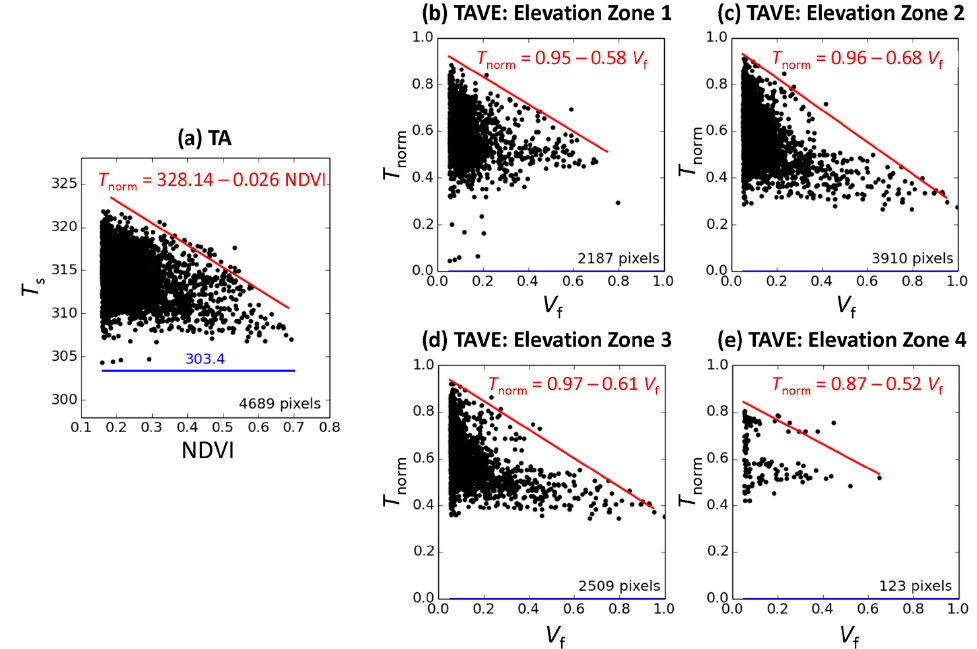
Figure 6. Comparison of temperature-vegetation triangles generated from ( a ) TA (a single triangle) and TAVE with four elevation zones: ( b ) − 420 m–580 m, ( c ) 80 m–1080 m, ( d ) 580 m–1580 m, and ( e ) above 1080 m. In ( b – e ), T norm and V f denote normalized land surface temperature and vegetative fraction, respectively. Red lines are linear regressions fits to the dry edges. In ( a ), the wet edge is indicated by the blue line. In ( b – e ), the wet edge is located on horizontal axis at T norm = 0. The number of pixels included in the triangle is shown on the lower right corner of each graph. Note that the total number of pixels in the four triangles of TAVE is larger than the number of pixels in the triangle of TA, because most of the pixels are involved in two overlapping elevation zones in TAVE.